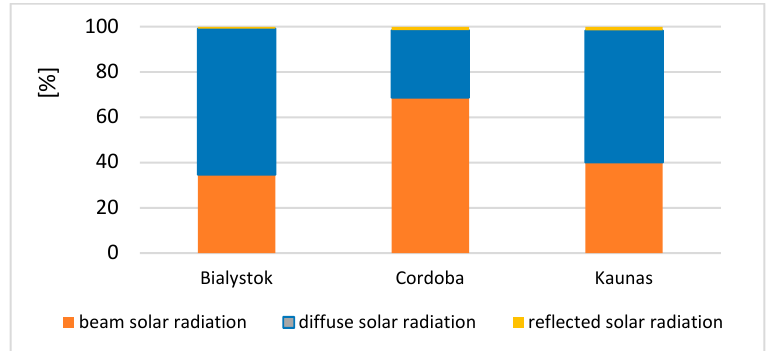
Figure 2. Contribution of beam and diffuse radiation in a total balance.